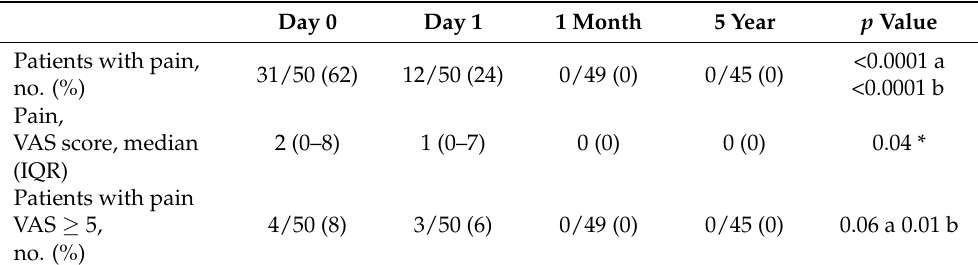
Table 4. Groin–thigh pain after TVT-A